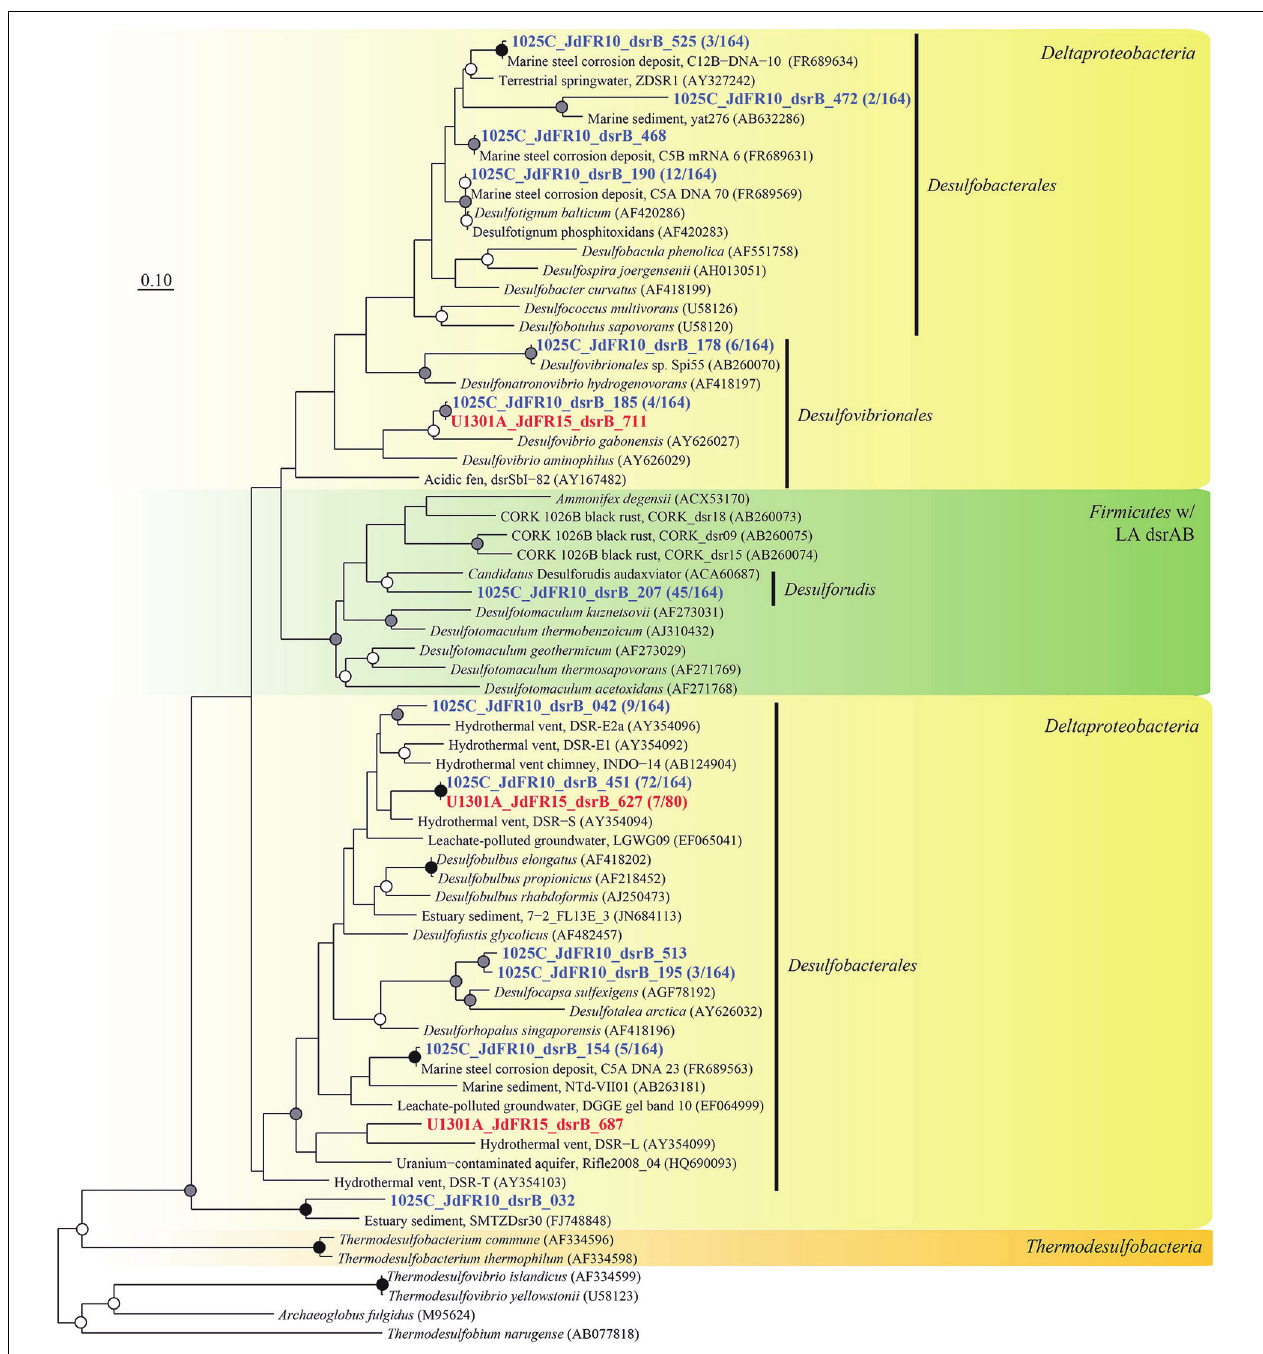
FIGURE 6 | Phylogenetic relationships of borehole fluid dsrB fragments from the Deltaproteobacteria class and Firmicutes phylum containing laterally acquired dsrAB . Gene clones recovered in this study are highlighted in bold font; the fractional abundance of identical clones